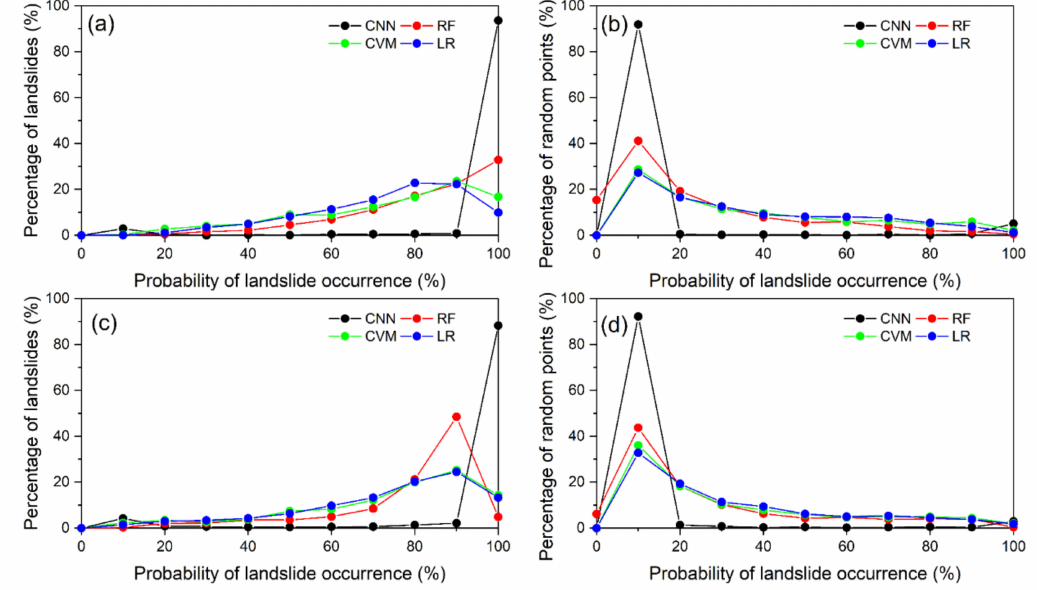
Figure 14. The distribution curves of the landslide and non-landslide points under different occur- rence probabilities: ( a , b ) refer to the Zhangzha Town, and the ( c , d ) refer to the Lantau